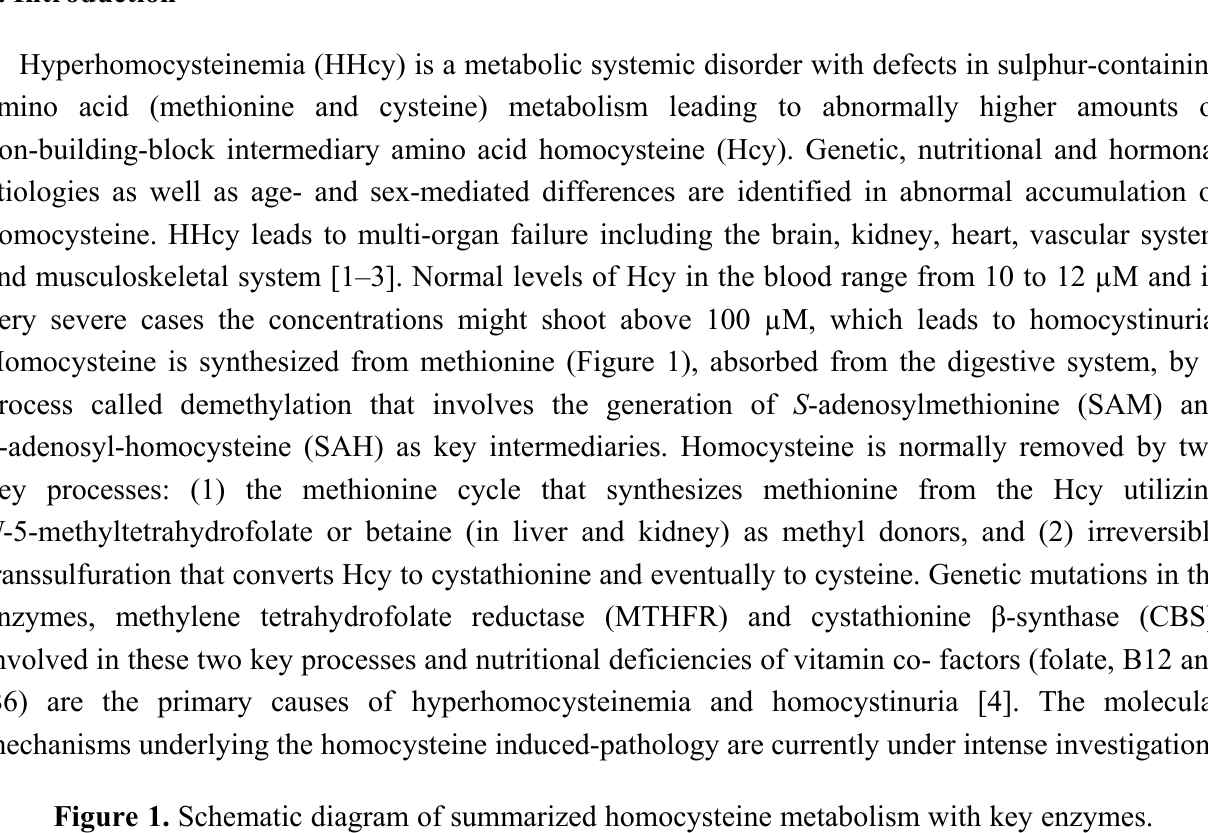
Figure 1. Schematic diagram of summarized homocysteine metabolism with key enzymes. THF (tetrahydrofolate); MTHFR (methylene tetrahydrofolate reductase); MS (methionine synthase); (cystathionine β -synthase); CTH (cystathionine γ -lyase). The enzymes are